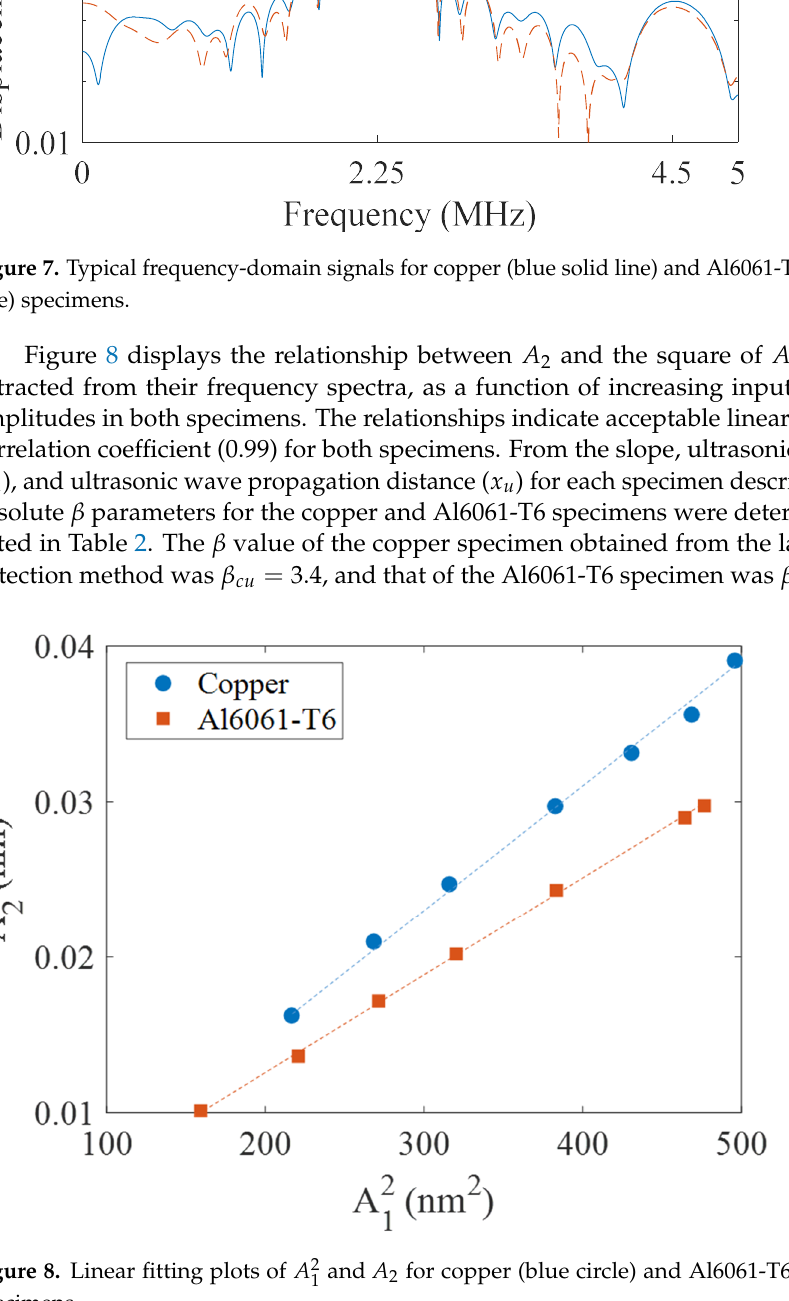
and A 2 for copper (blue circle) and Al6061-T6 (brown square) 1